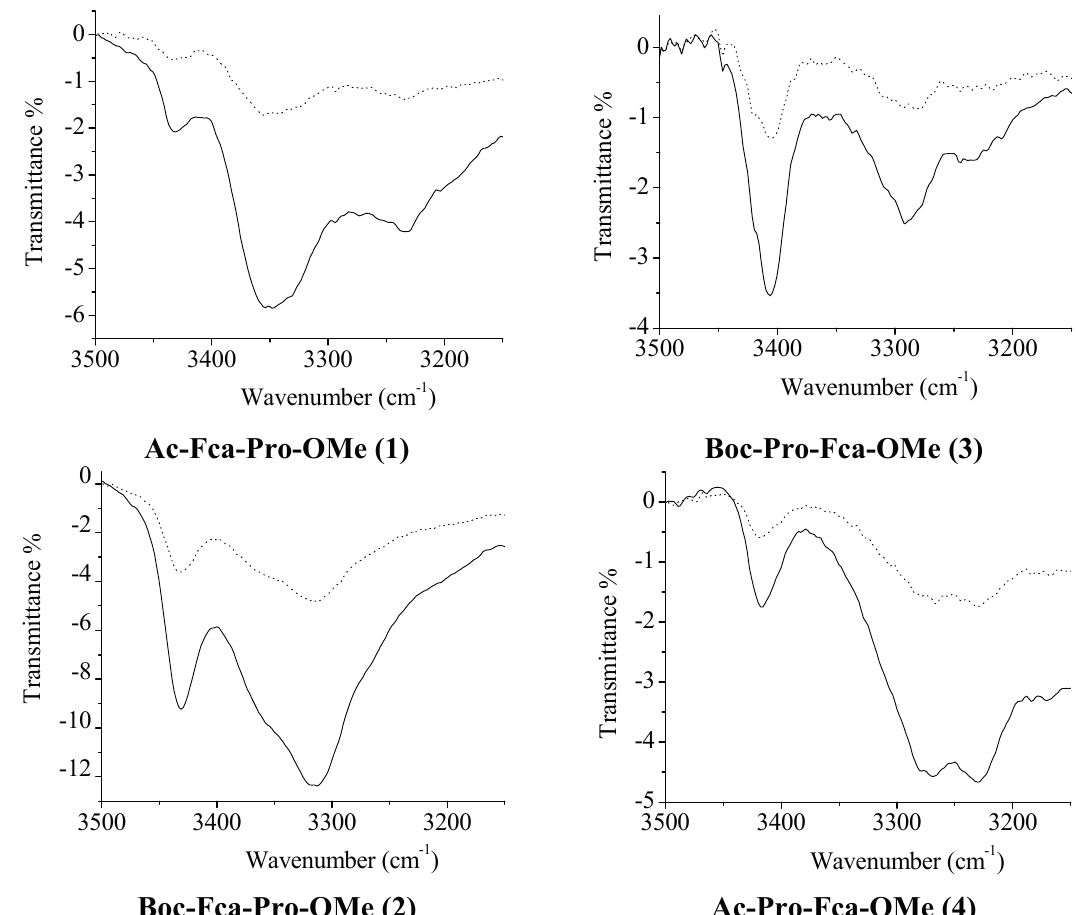
Figure 1. The NH stretching vibrations in concentration-dependent IR spectra of 1 – 4 in CH Cl (solid line: c = 5 × 10 − 2 M, dashed line: c = 5 × 10 − 4 2 2